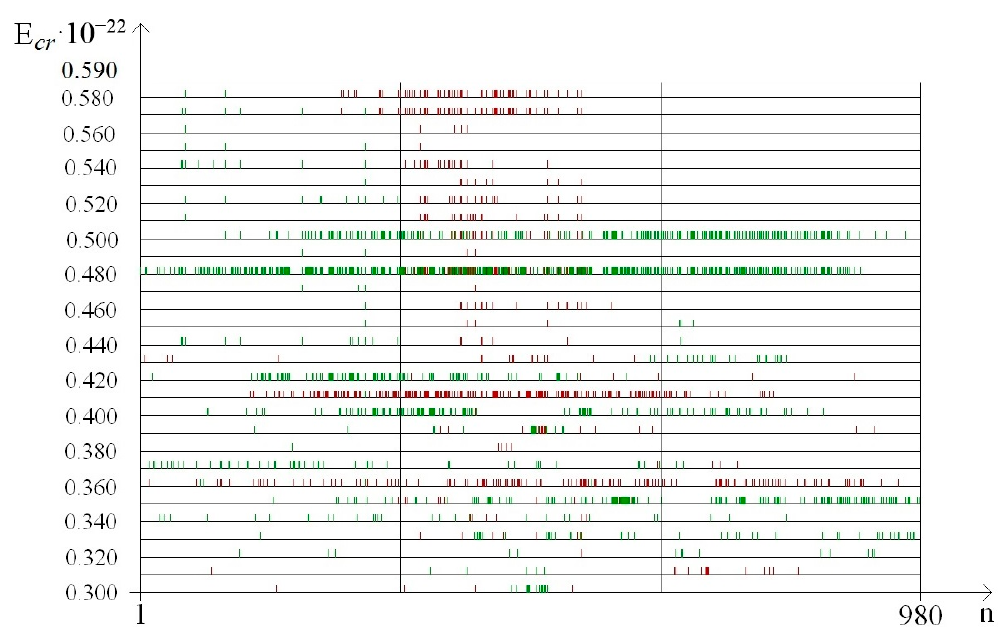
Figure 5. Distribution in the different parts of IFNA17 of nucleobase pairs (which was counted by Basov-Jimack algorithm) leading after the single 2 H/ 1 H replacement the extreme frequency of OS occurrence. Note: red dot is the location of the deuterium atom in the DNA molecule, which leads to the maximum probability of OS occurrence (range); green dot is the location of the deuterium atom in the DNA molecule, which leads to the minimum probability of OS occurrence (range). Table 4. Quantity of the n min and n max in double-stranded DNA dependent on single 2 H/ 1 H replacement was counted by different approaches in some ranges of the E Hcr.